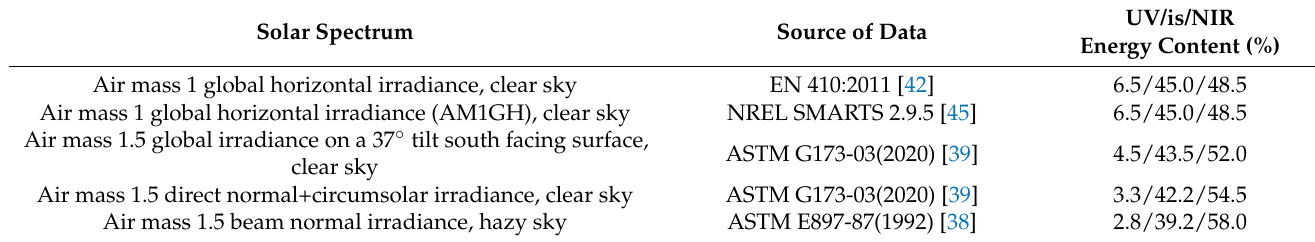
Table 1. Energy content of alternative solar spectra in the ultraviolet (UV), visible (Vis), and near-infrared (NIR) ranges. Solar